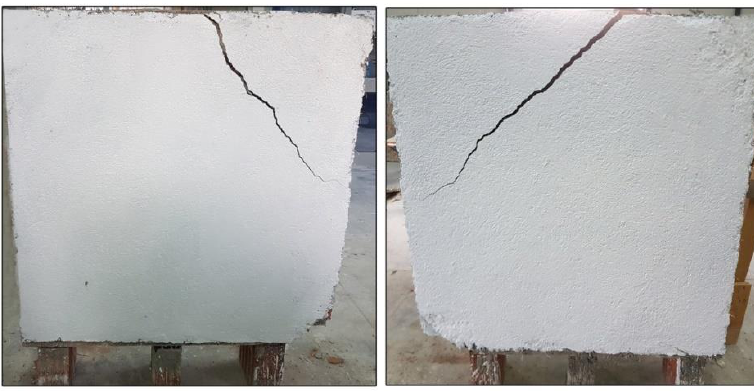
Figure 17. Failure mode of W-6-PF.